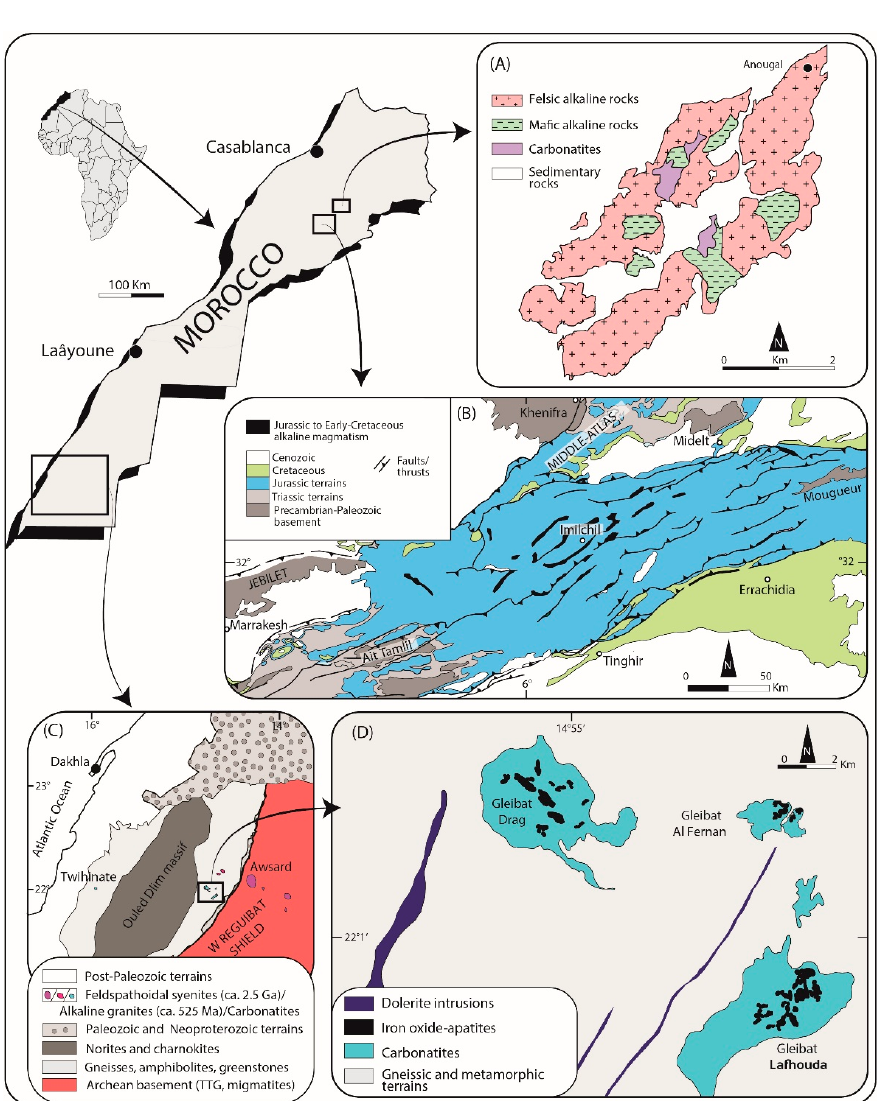
Figure 11. Simplified geological maps of: ( A ) the Tamazeght alkaline–carbonatite massif (adapted from [120]), ( B ) the Imilchil alkaline complex (adapted from [19,126]), ( C ) geological map of the West Reguibat area showing the main alkaline magmatic occurrences of southern Morocco (adapted from [20,117]), and ( D ) the Gleibat Lafhouda carbonatite complex (adapted from [20,117]).